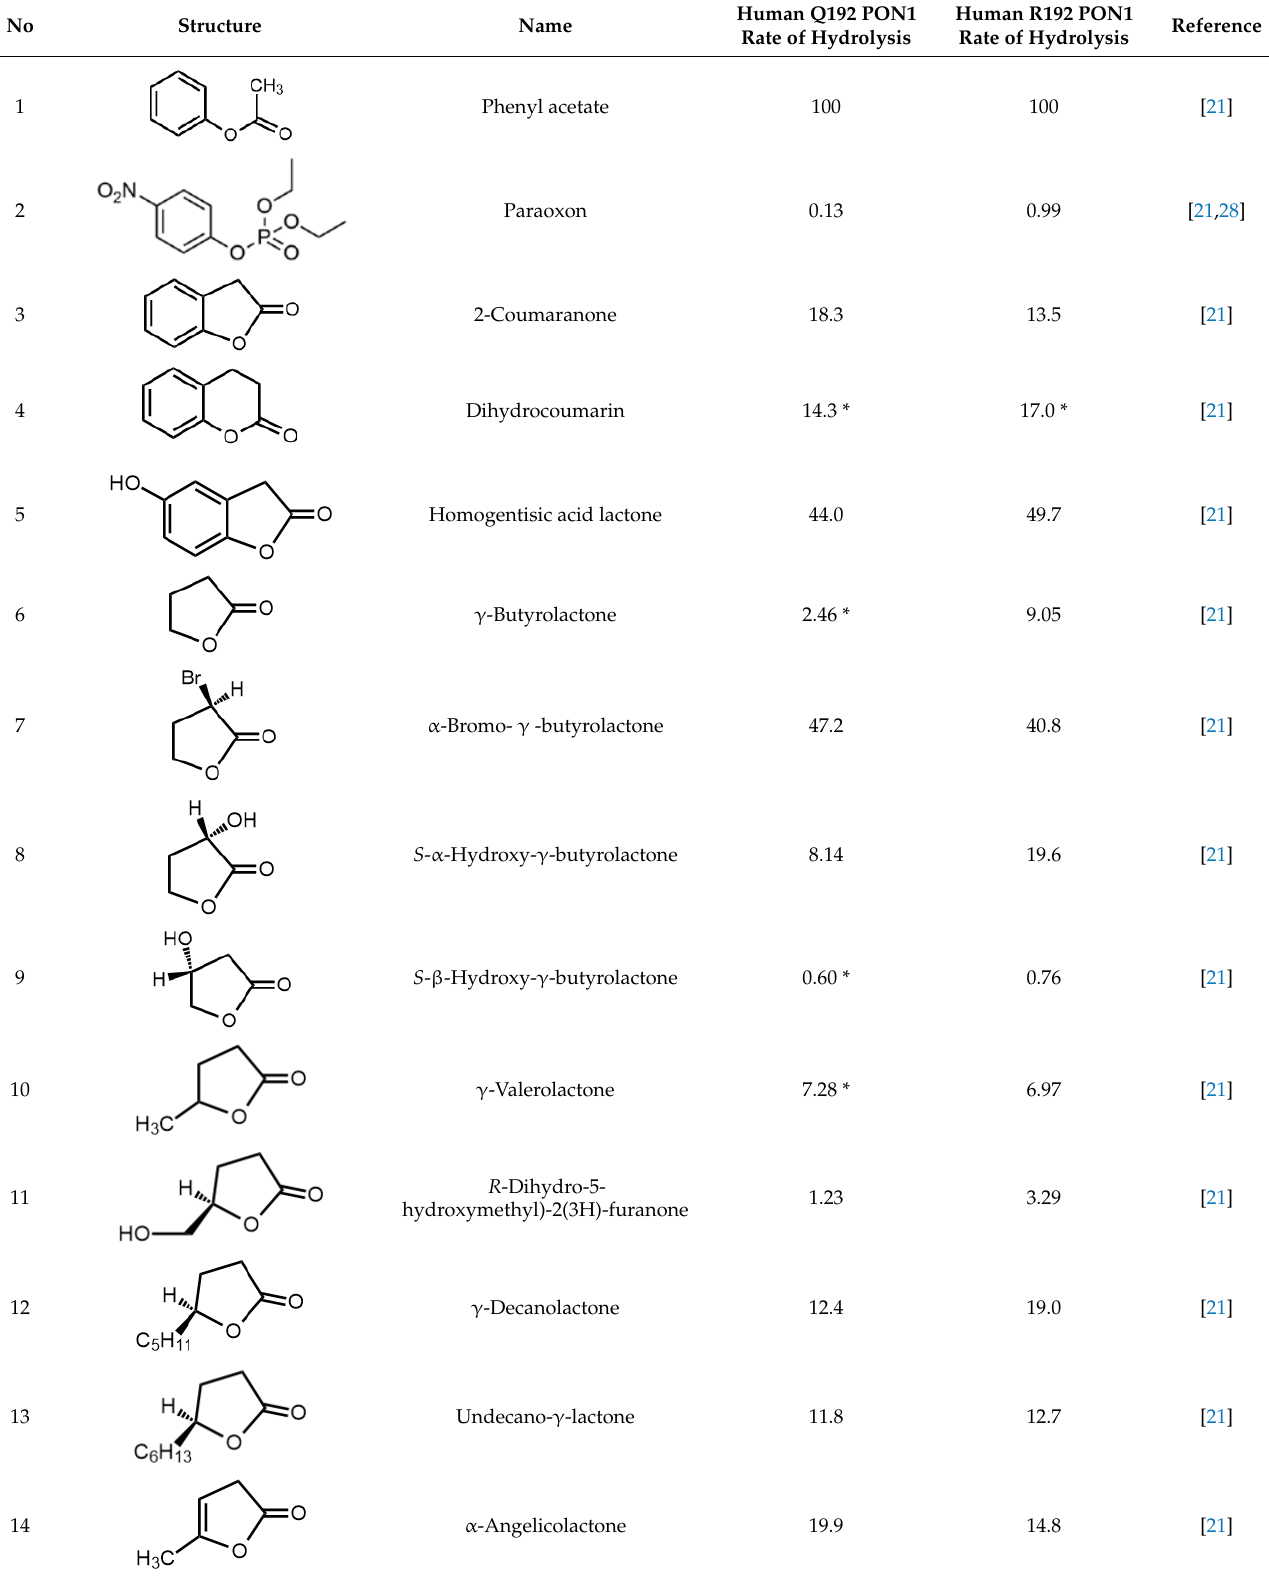
Table 1. The substrates used in the present study and their experimentally measured rate of hydrol- ysis [21,28] by QPON1 and RPON1 at [substrate] = 1mM.